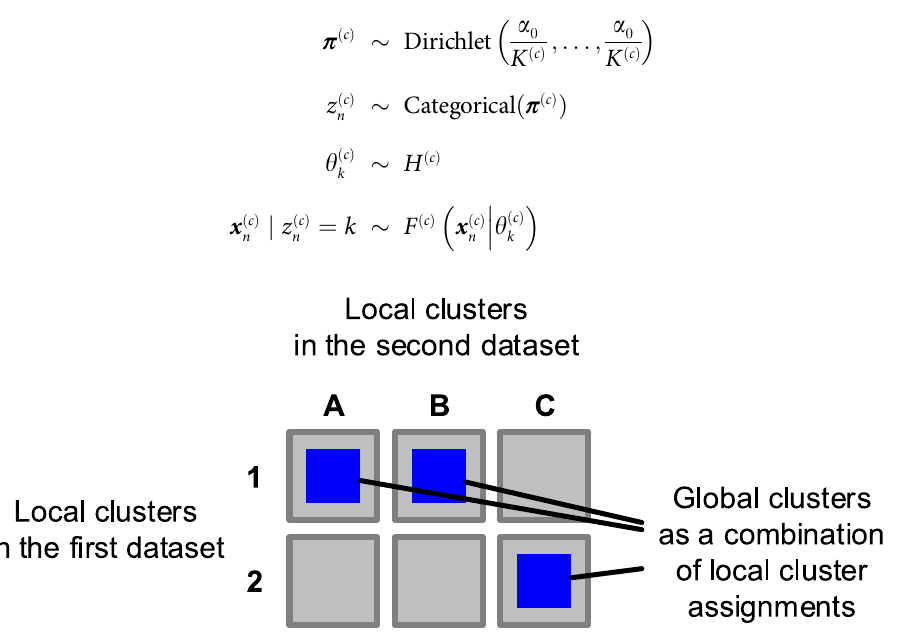
Fig 21. Illustration of the concepts of global and local clusters. The first dataset containstwo clusters 1 and 2, the second dataset containsthree clusters, A , B and C . The combinedstructure containssix potential globalclusters that correspondto combinations of assignments on the local context